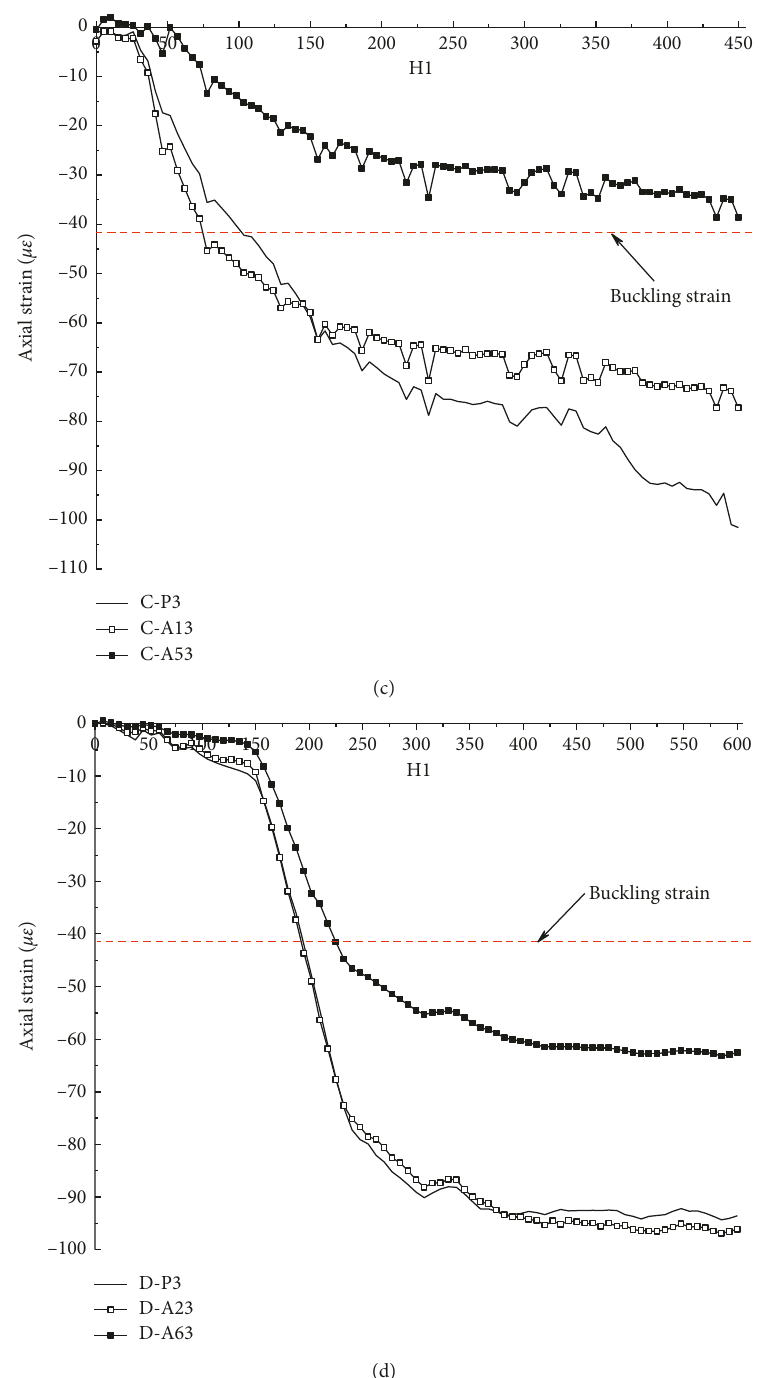
Figure 12: Comparison of the distribution of axial strains and the buckling strain under pure gravity